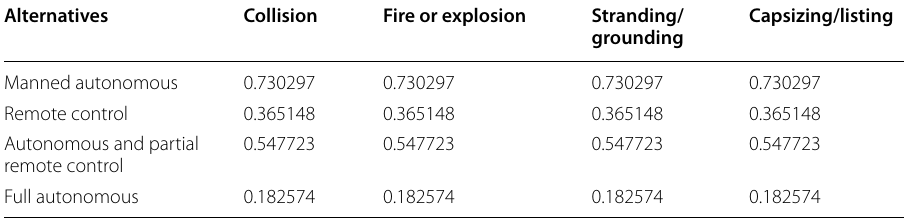
Table 7 Normalized matrix of